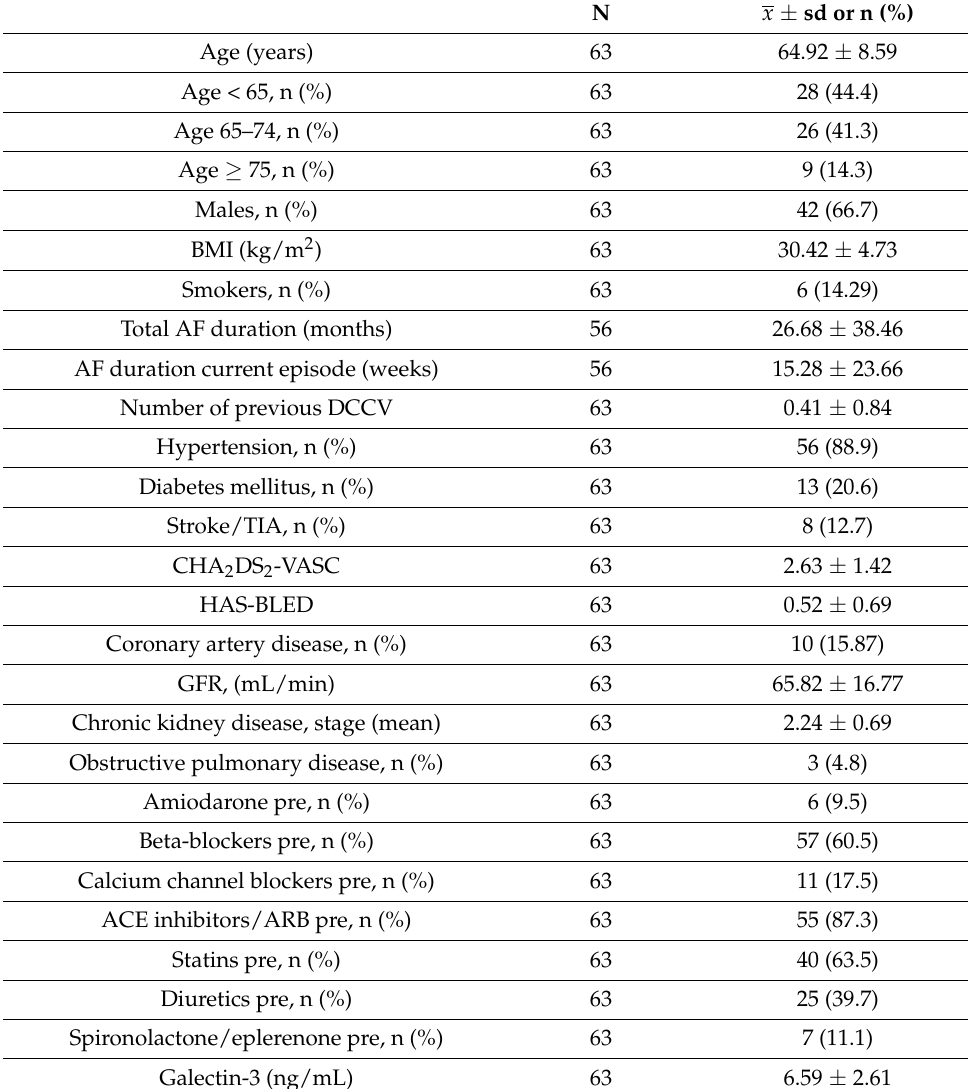
Table 1. Clinical